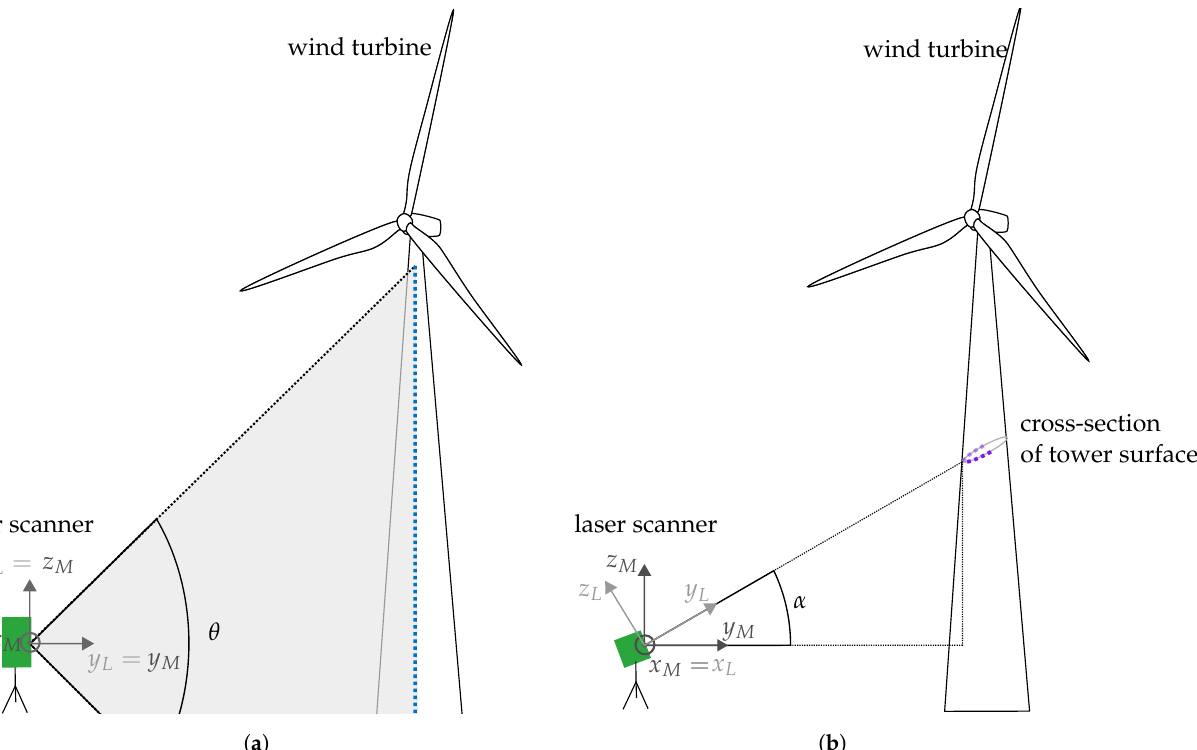
Figure 1. Sketch of the measurement arrangement showing the laser coordinate system ( x L , y L , z L ) and the measurement coordinate system ( x M , y M , z M ) . ( a ) Side view of the vertical alignment of the laser scanner with the fixed scan angle θ . Note that the scan was performed in the y L − z L plane. ( b ) Side view of the horizontal alignment of the laser scanner with an inclination angle α . Note that the scan was performed in the x L − y L